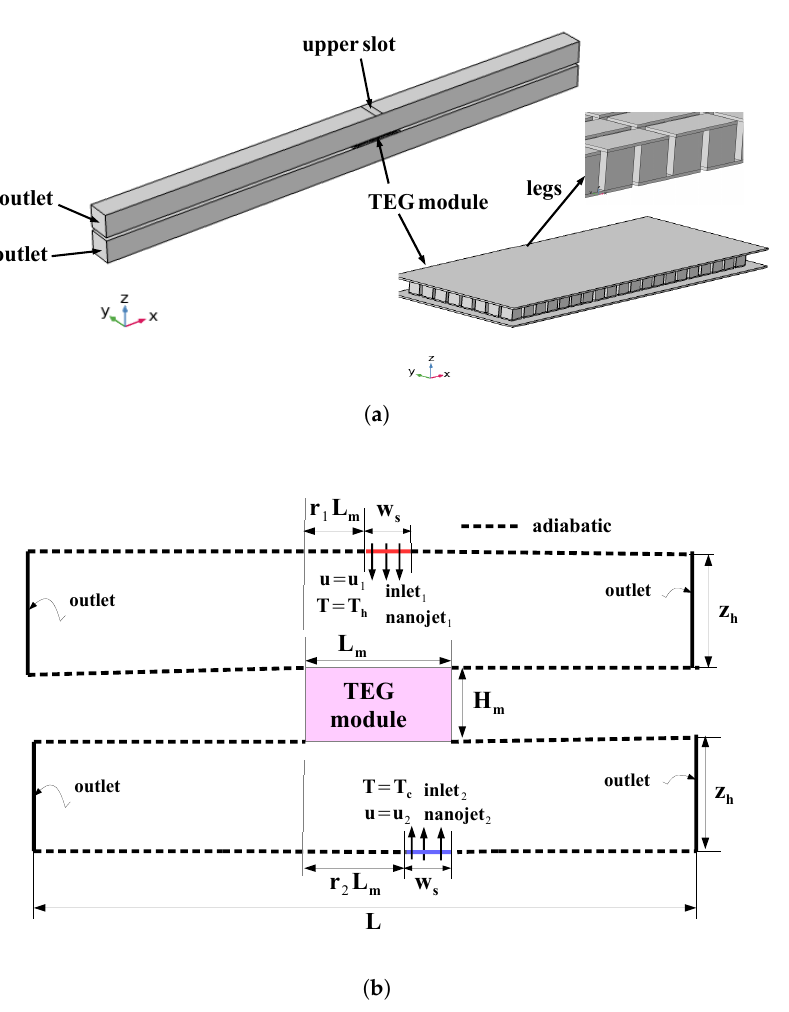
Figure 1. 3D schematic view of confined nanojet impinging system with TEG module ( a ) and 2D representation with boundary conditions ( b ). Table 1. Material properties of thermoelectric generator (TEG)